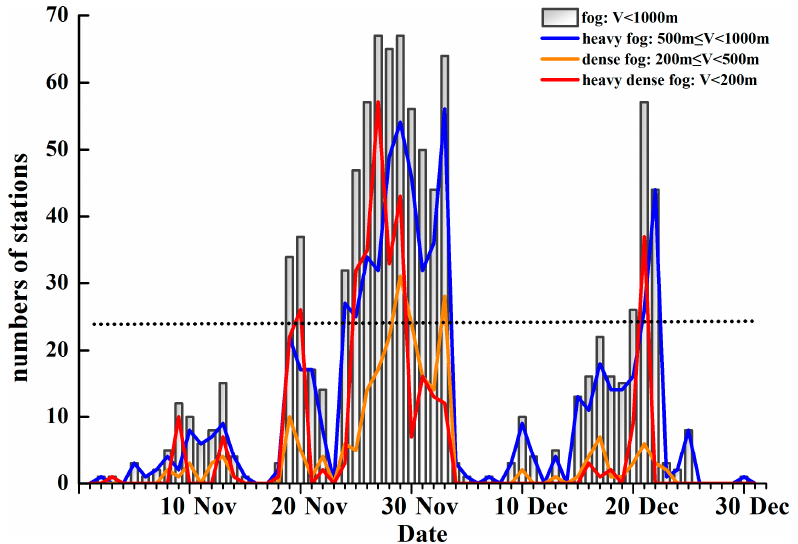
Figure 1. The daily numbers of stations with the occurrence of fog (mean daily visibility less than 1000 m, bars), heavy fog (visibility less than 1000 m and more than 500 m, blue line), dense fog (visibility less than and equal to 500 m and more than 200 m, orange line) and strong dense fog (visibility less than 200 m, red line) events over Jiangsu Province in China. The dotted line denotes 24 stations, which are about one-third of all the 70 stations over Jiangsu Province.